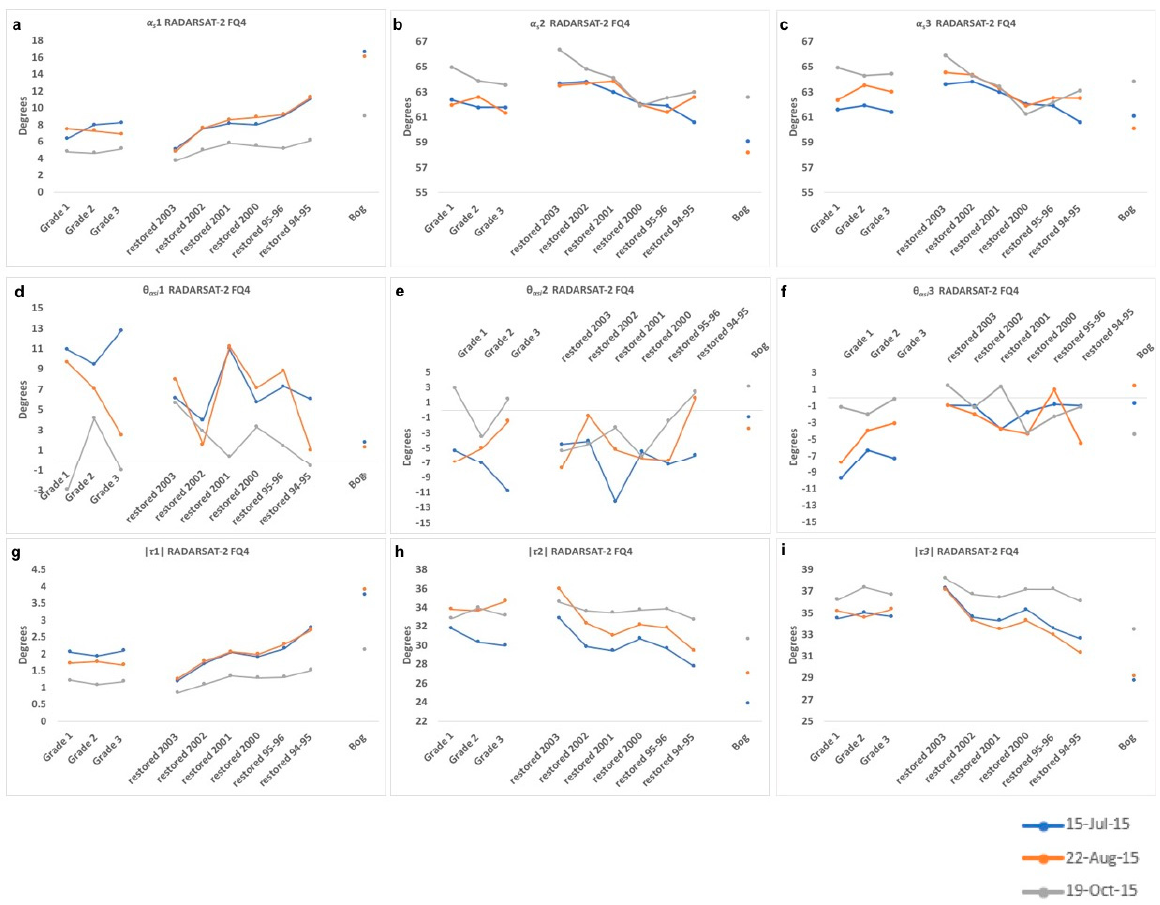
Figure 6. Spectral signatures for natural shrub bog, harvested peat, and restored peat using RADARSAT-2 FQ4 imagery. ( a – c ) Dominant, secondary, and tertiary scattering-type magnitude, ( d – f ) dominant, secondary, and tertiary scattering-type phase, and ( g – i ) dominant, secondary, and tertiary absolute value of helicity, respectively.